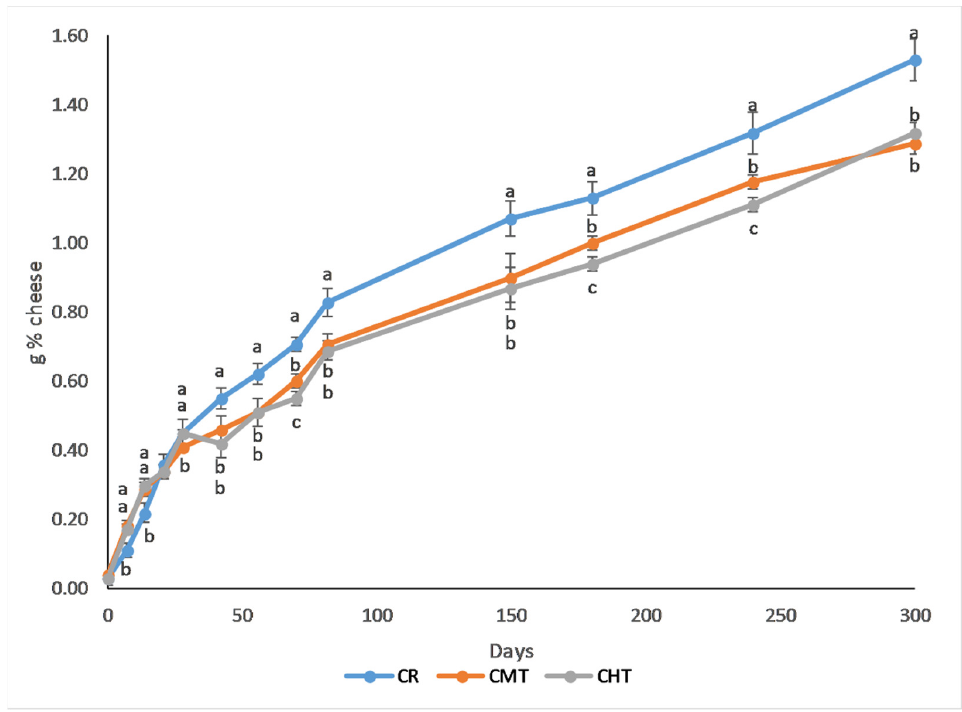
Figure 7. Evolution of the soluble nitrogen fraction in Canestrato Pugliese cheese made from raw and thermized milk. Different letters for the same ripening time indicate different values at p > 0.05; no letters means no difference.